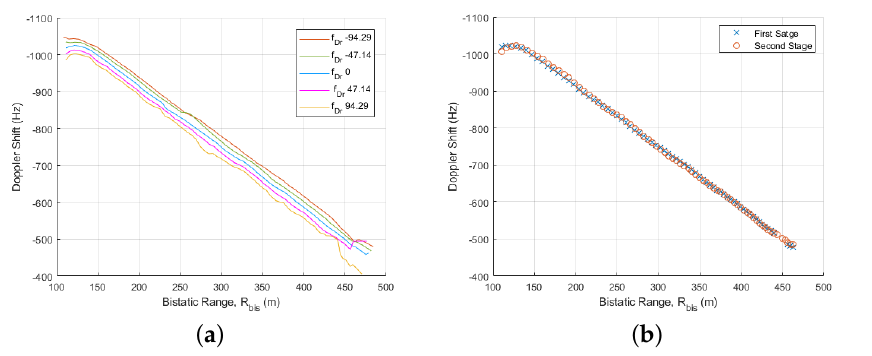
Figure 15. Results associated with Doppler migration compensation bank filter. ( a ) Bistatic tracker re- = {− 94.29, − 47.14,0,47.14,94.29 } Hz/s. ( b ) Tracker performances sults for filters designed with f i Dr for the collaborative target are provided by the first and second stages of the proposed